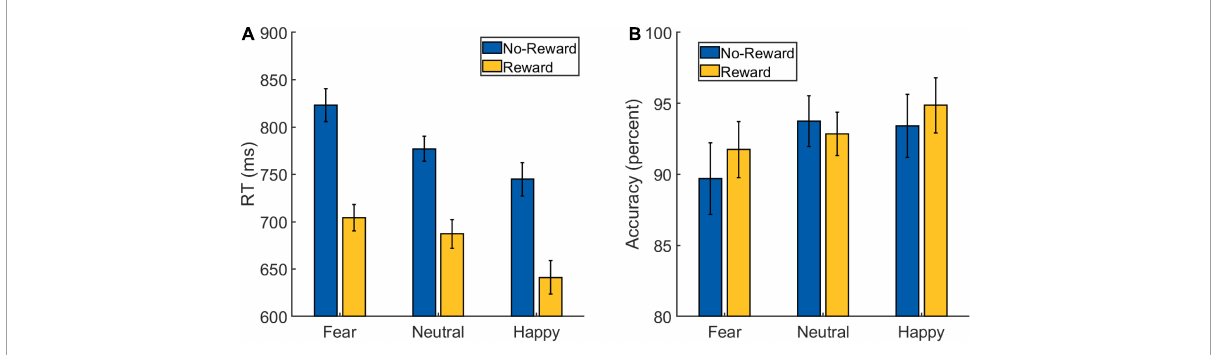
FIGURE2 Behavioral data from the Main Task Phase of Experiment 1: (A) reaction time (RT) and (B) accuracy scores. The error bars represent confidence intervals ( ± 1.96 × within-subject Standard Error) as discussed in O’Brien and Cousineau